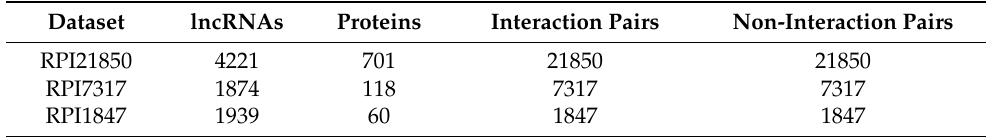
Table 1. Numeric description of the